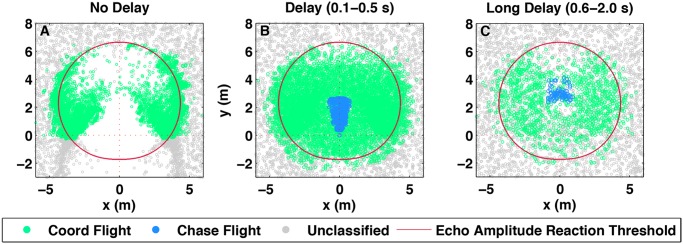
Model-generated spatio-temporal trajectories.BSMI model output of the actor’s locations relative to the reactor, according to the TDDC and TDDS analysis, for different delayed response scenarios, each with echo amplitude reaction threshold at 10 dB. The blue and green points represent chase and coordinated flight respectively. The grey points represent non-interacting flights for which, having neither actor nor reactor, one of the pair was randomly placed at the center. (A) Spatial patterns when alignment response is immediate; when delay values are multiple of 100 ms and up to 500 ms; and (C) with reaction delay values multiple of 100 ms and between 600 ms and 2 s. For clarity only around three thousand randomly selected grey points have been plotted in each panel. Only short delay values, panel (B), reproduce the observed spatial relationship in Fig. 2 where actors are aligned within the sound field contour and chasees occupy the forward position directly in front of the chaser. Panels (A) and (C) corresponding to the model with instant and long delays respectively, fail to produce the same populating of the sound field and have chases absent or present at greater separations than recorded in the field, respectively.